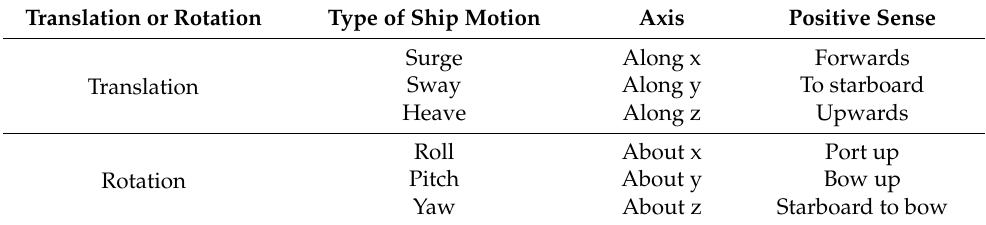
Table 3. Ship motion.